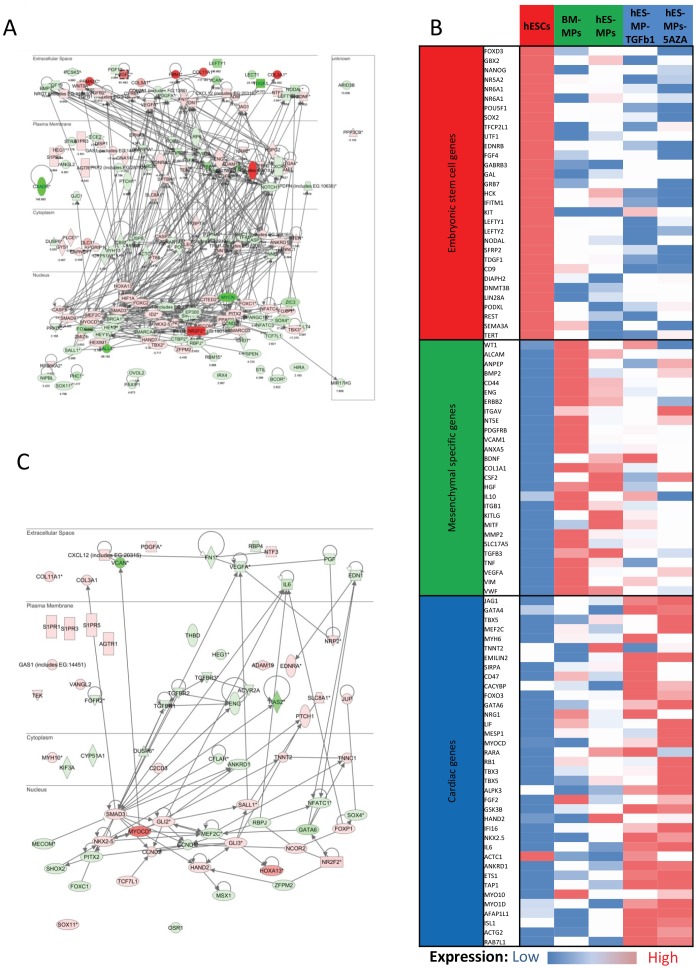
Level of expression of embryonic stem cell, mesenchymal and cardiac specific genes in hESC-MPs.A. Genes involved in cardiomyocyte development were retrieved using IPA canonical gene list from the transcriptomic analysis of hESC-MPs compared to hESCs. Network representing expression and cellular localization of the genes retrieved. Up-regulated (red), down-regulated (green) in hESC-MPs compared to hESCs. B. Schematic representation of level of expression of selected genes (red: higher expression level; blue: lower level of expression). While embryonic stem cells genes are overexpressed by hESCs; hESC-MPs and BM-MPs overexpress mesenchymal genes and cardiac markers are more abundant in 5-AZA or TGF-β1 treated cells. C. Network representing expression and cellular localization of genes involved in cardiomyocyte differentiation, up-regulated (red) or down-regulated (green) in hESC-MPs compared to BM-MPs.